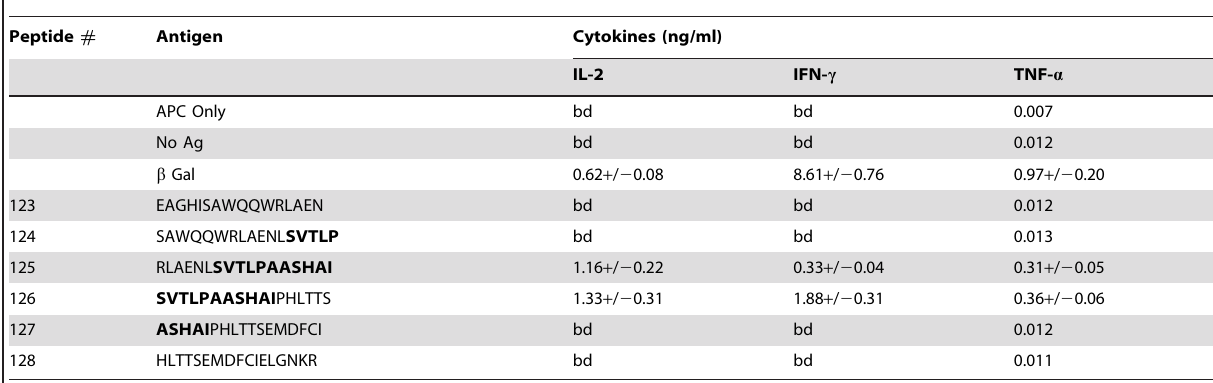
Table 1. Mapping of the BG2 b -gal-specific T CD4 +